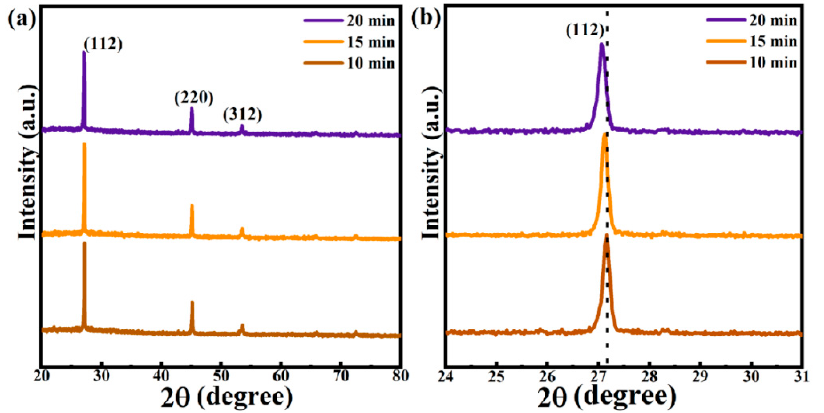
Figure 2. ( a ) XRD patterns of CNZTSSe films selenized at various selenidation times; ( b ) Enlarged images of (112) peaks of CNZTSSe films selenized at various selenidation times.